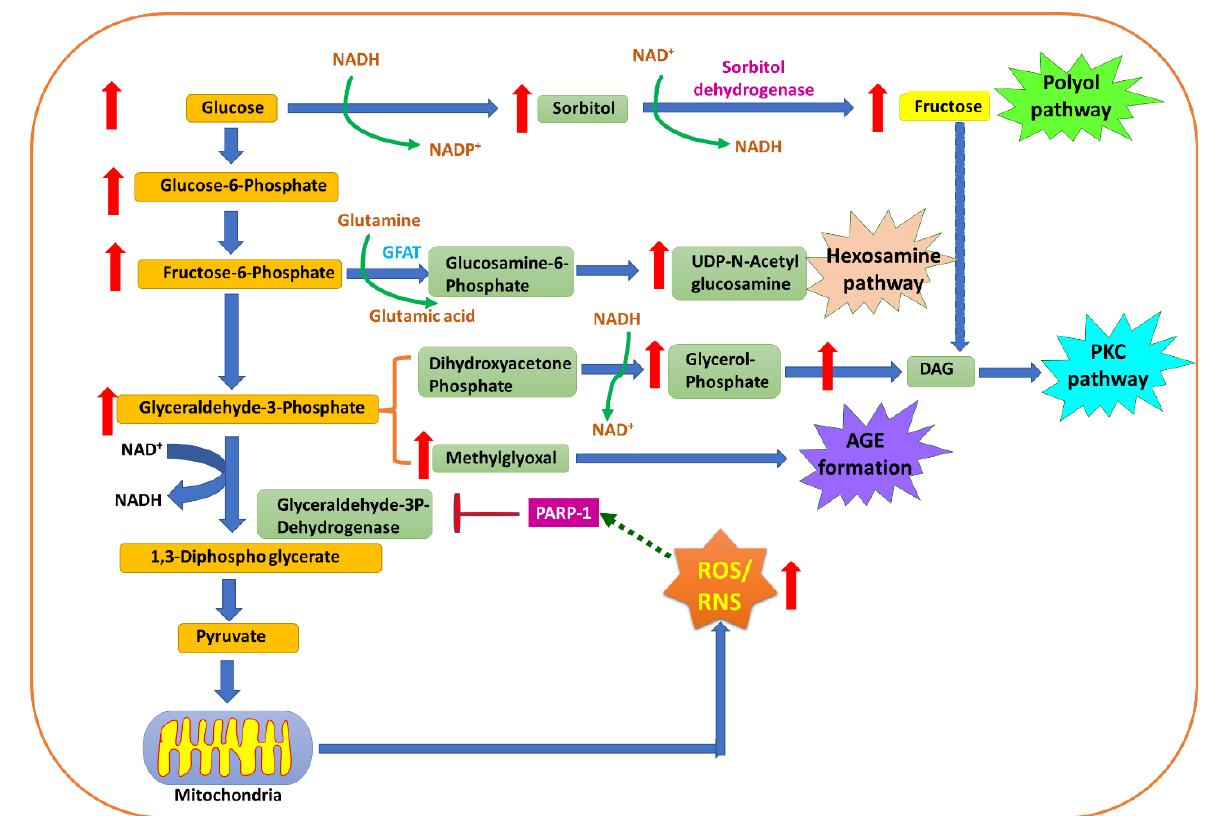
Figure 3. Pathways (glucose metabolism) and products which mediate oxidative stress.